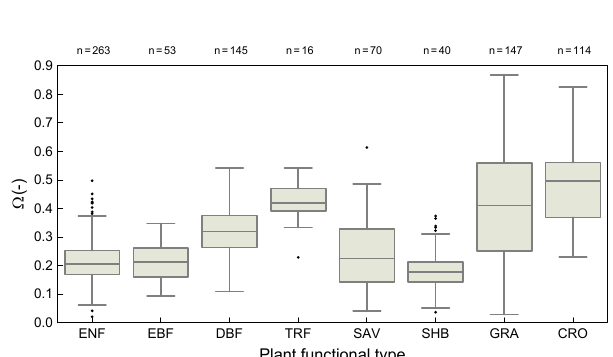
Figure A1. Box and whisker plot (line, median; box, inter- quartile range) showing the estimated coupling coefficient ( (cid:127) ) from FLUXNET2015 data grouped by plant functional type. Whiskers extend to 1.5 times the inter-quartile range, with dots outside of the whiskers showing outliers. Plant functional types are defined as ENF – evergreen needleleaf forest, EBF – evergreen broadleaved forest, DBF – deciduous broadleaved forest, TRF – tropical rain for- est, SAV – savanna, SHB – shrub, GRA – grasses, C3C – C 3 crops, and C4C – C 4 crops. Values of n indicate the number of site years for FLUXNET.